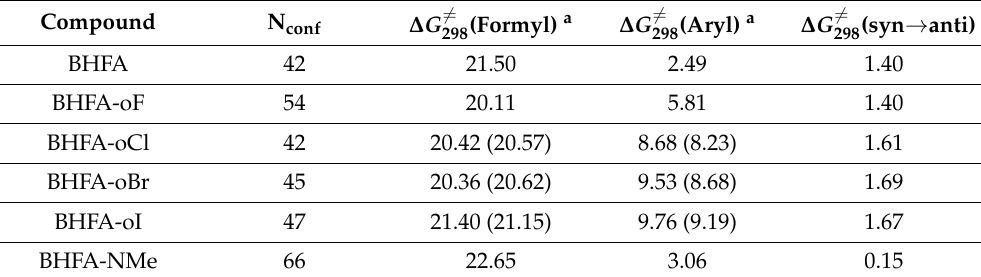
Table 1. The number of conformations (N conf ) found using the VeraChem software, the barriers ( ∆ G (cid:54) = (Formyl) and ∆ G (cid:54) = (Aryl)) for the rotation of the formyl and aromatic fragments of the 298 298 investigated compounds. Values of ∆ G (cid:54) = ( syn → anti ) correspond to internal rotation of the formyl 298 group. Gibbs energies are given in kcal/mol. Compound N conf ∆ G (cid:54) = (Formyl) a ∆ G (cid:54) = (Aryl) a 298 298